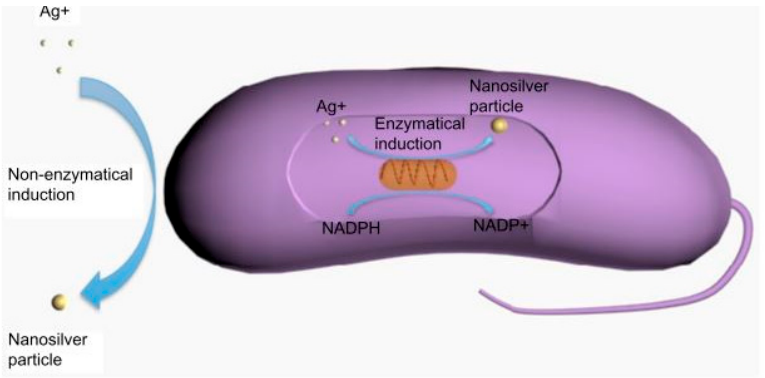
Figure 4. Biological synthesis of Ag NPs. Reproduced with permission from Dovepress, 2014 [105].